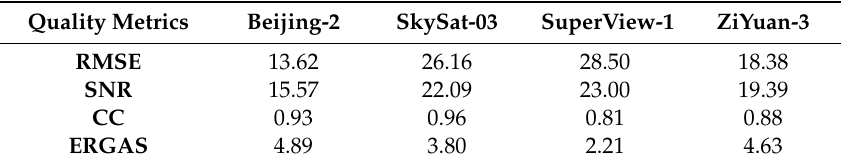
Figure 6. Fusion results of different data, where ( a1 ) is the up-sampled multi-spectral image of Beijing-2, ( a2 ) is fused image of Beijing-2, ( b1 ) is the up-sampled multi-spectral image of SkySat-03, ( b2 ) is the fused image of SkySat-03, ( c1 ) is the up-sampled multi-spectral image of SuperView-1, ( c2 ) is the fused image of SuperView-1, ( d1 ) is the up-sampled multi-spectral image of ZiYuan-3, and ( d2 ) is the fused image of ZiYuan-3. Table 5. The evaluation parameters of different data.